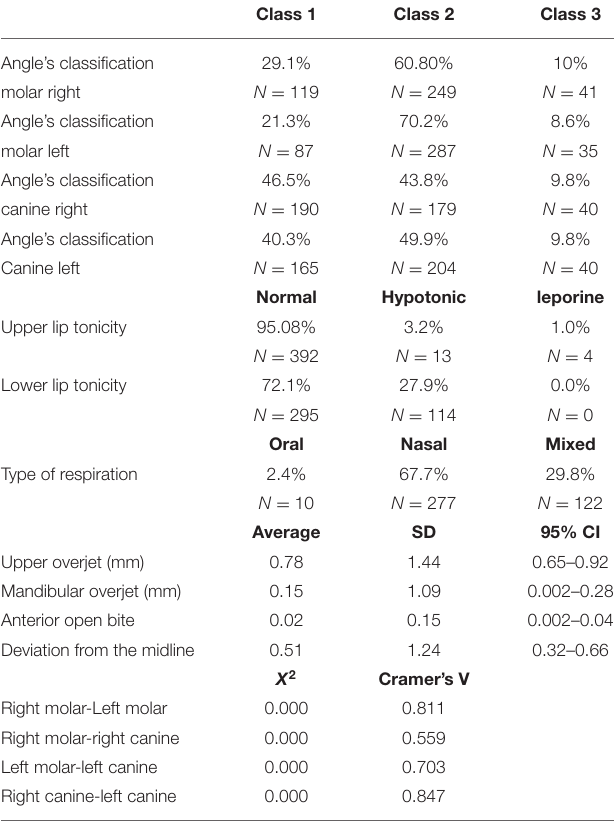
TABLE 2 | Oral assessment of participants. TABLE 3 | Inferential analysis between Angle’s classification and foot